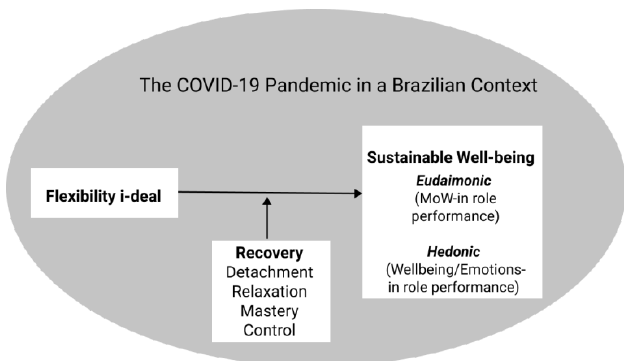
Figure 2. Theoretical model.